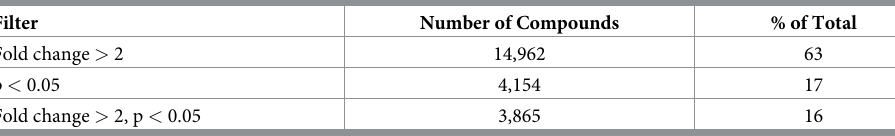
Table 1. An overview of the detected compounds from the LCMS data.